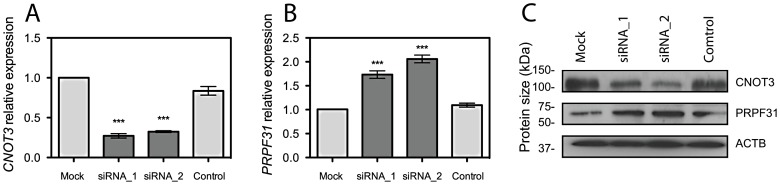

CNOT3 silencing stimulates PRPF31 expression in ARPE-19 cells.(A) CNOT3 mRNA depletion by 2 different siRNA sequences and its effect on PRPF31 mRNA expression (B). ***, p<0.001. (C) Representative western blot of CNOT3 silencing and effect on PRPF31 protein expression. siRNA_1 and siRNA_2, different CNOT3-specific siRNA sequences; Control, treatment with transfection reagent with no siRNA; Mock, treatment with transfection reagent and scrambled siRNA.